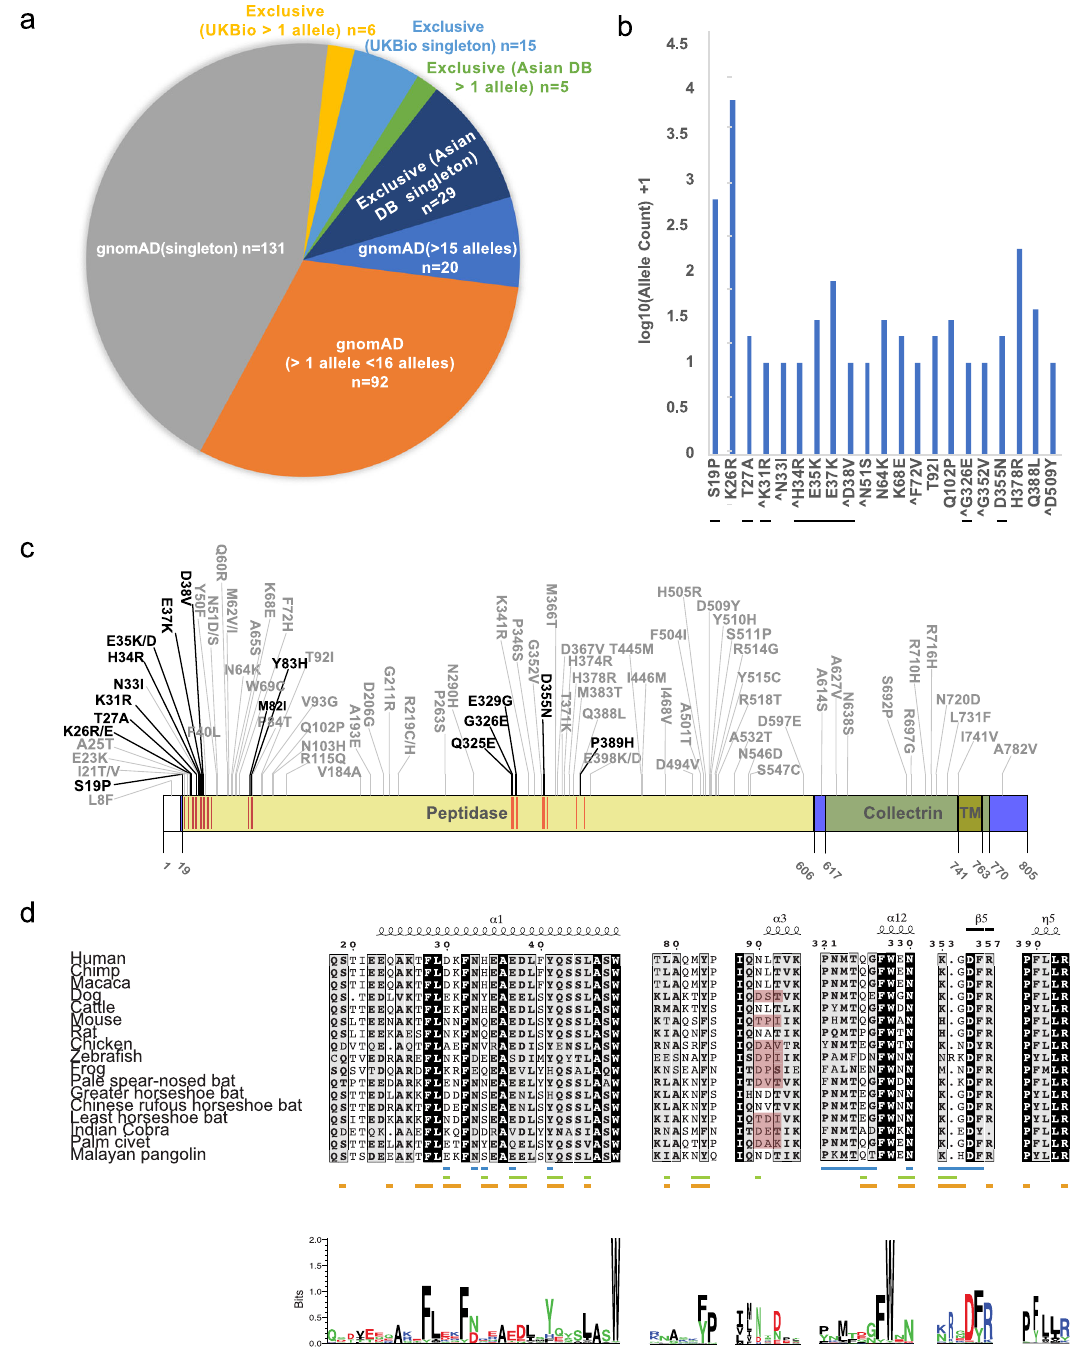
Fig. 1 ACE2 polymorphisms. a Pie chart representing protein altering variations in ACE2 by allele count and source. b Log base 10 pseudo count adjusted ( + 1) observed ACE2 allele counts of mutants predicted to impact S-protein binding. Singletons are marked with a ^ and direct S-protein contact residues are underlined. c ACE2 protein domain showing positions with polymorphisms that can alter SARS-CoV-2 S-protein binding. Recurrent polymorphisms ( n > 1) that were predicted to not impact S-protein binding are shown in light grey. Residues within the ACE2 peptidase domain (PD) known to interact with viral S-protein are shown as red vertical lines within the peptidase domain in the ACE2 diagram. d Multiple sequence alignment of the S-protein interacting ACE2 sequence from indicated species. ACE2 NxT/S glycosylation motif disrupted in dog, rat, palm civet, and several bat ACE2 is highlighted in red. ACE2 residues that mediate contact with NL63-CoV, SARS-CoV and SARS-CoV-2 are shown as blue, green and orange bars, respectively.